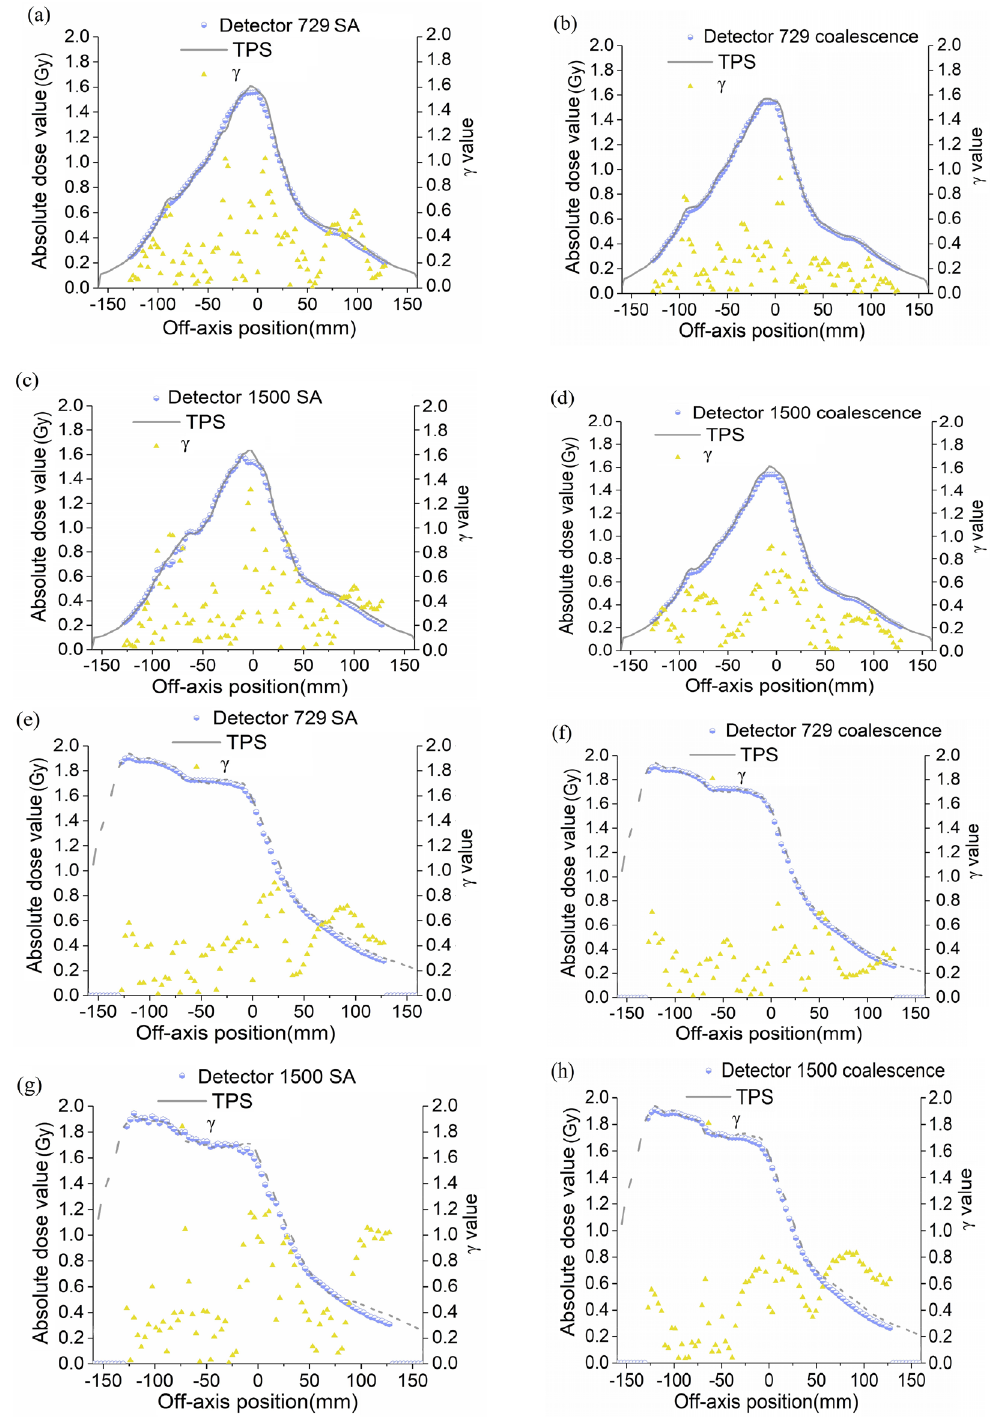
Figure 7. Dose profile comparison of transverse view between measured and calculated dose distribution in an abdominal 6 MV VMAT plan. (a–d) Dosimetric profile representations of SA and coalescence results along the lateral left and right directions in detectors. (e–h) Dosimetric profile representations of SA and coalescence results along the positive slope diagonal (from the upper left to the lower right) in